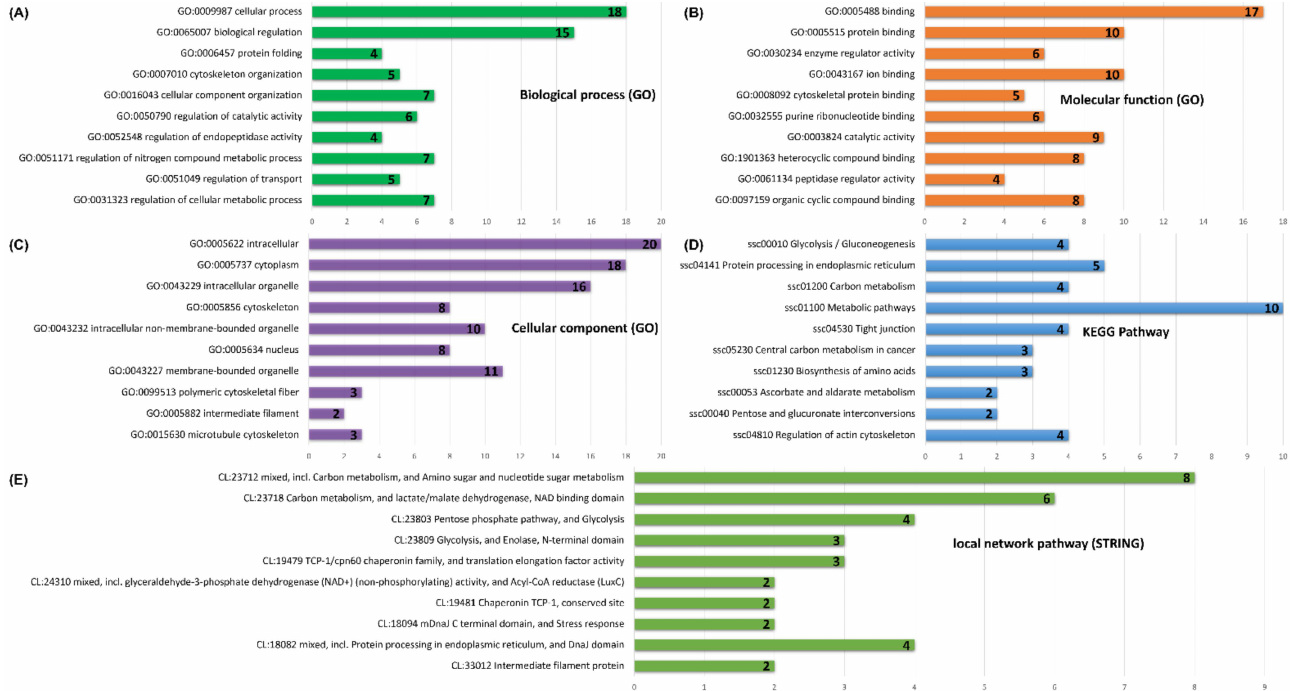
Figure 2. The top ten (the most statistically significant according to Benjamini–Hochberg FDR) predicted enrichment function and pathway terms of porcine cecal proteins retrieved from the STRING database: ( A ) Classification of proteins based on Gene Ontology (GO) biological process; ( B ) classification of proteins based on GO molecular function; ( C ) classification of proteins based on GO cellular component; ( D ) pathway analysis of proteins assessed by the KEGG classification; ( E ) pathway analysis of proteins identified by the local network cluster (STRING)